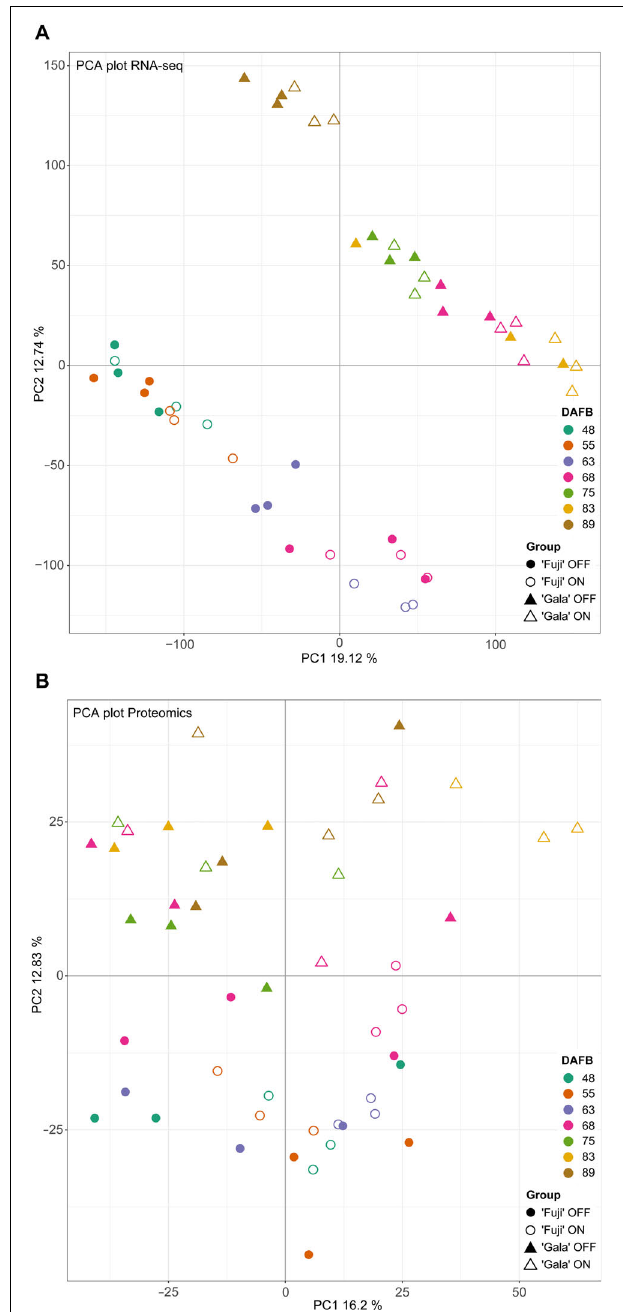
FIGURE 4 | PCA analysis of transcriptomic (A) and proteomic (B)